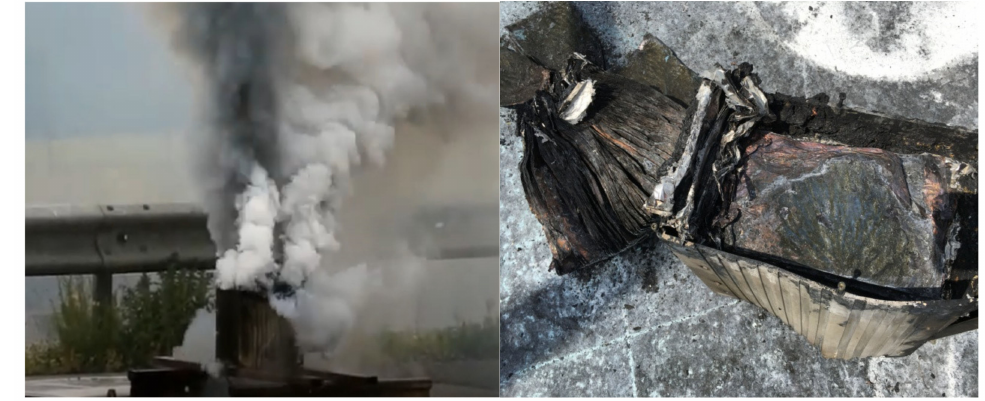
Figure 18. Exp. A.4